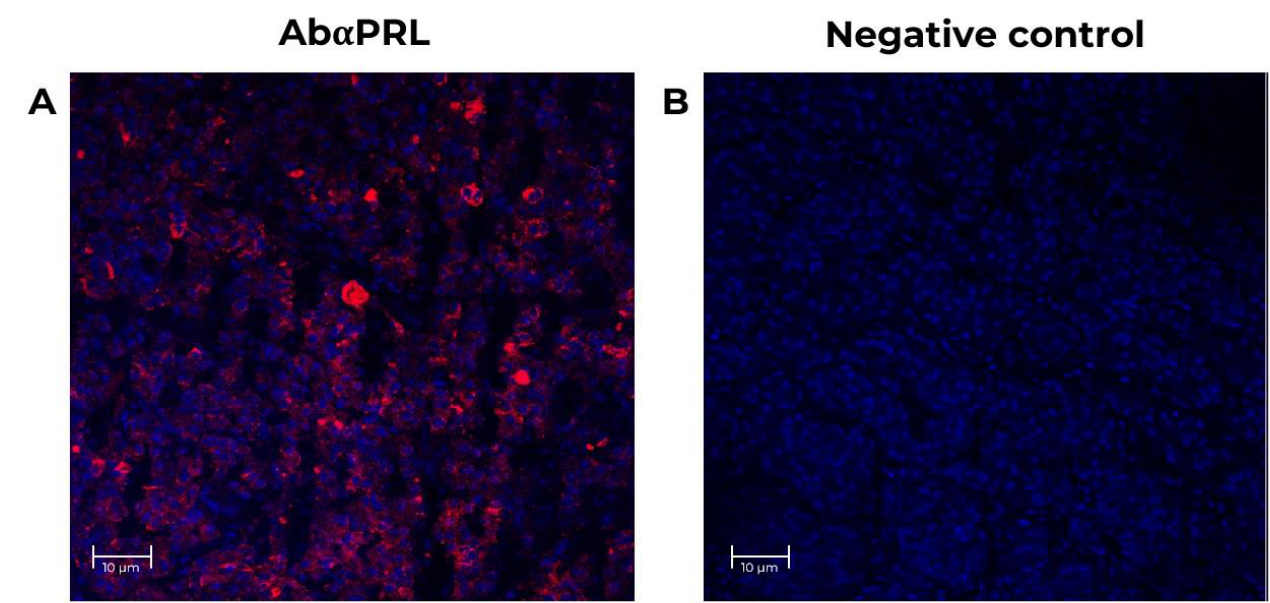
Figure 4. Positive control for specificity PRL antibodies in the neural retina from adult female baboons. The tissues correspond to fetus baboon ID 12354. ( A ) Confocal images of stained baboon adult pituitary sections to identify cells expressing PRL (red, 1st Ab: mouse anti-human PRL 1:100; goat anti-mouse IgG Cy5 1:4000) in lactotrophs adult baboon pituitary. Nuclei (blue) were labeled with DAPI. ( B ) Negative control with no primary antibody (mouse anti-human PRL 1:100, red signal) in baboon pituitary slices, at 25X magnification, scale-bar 10 µm.